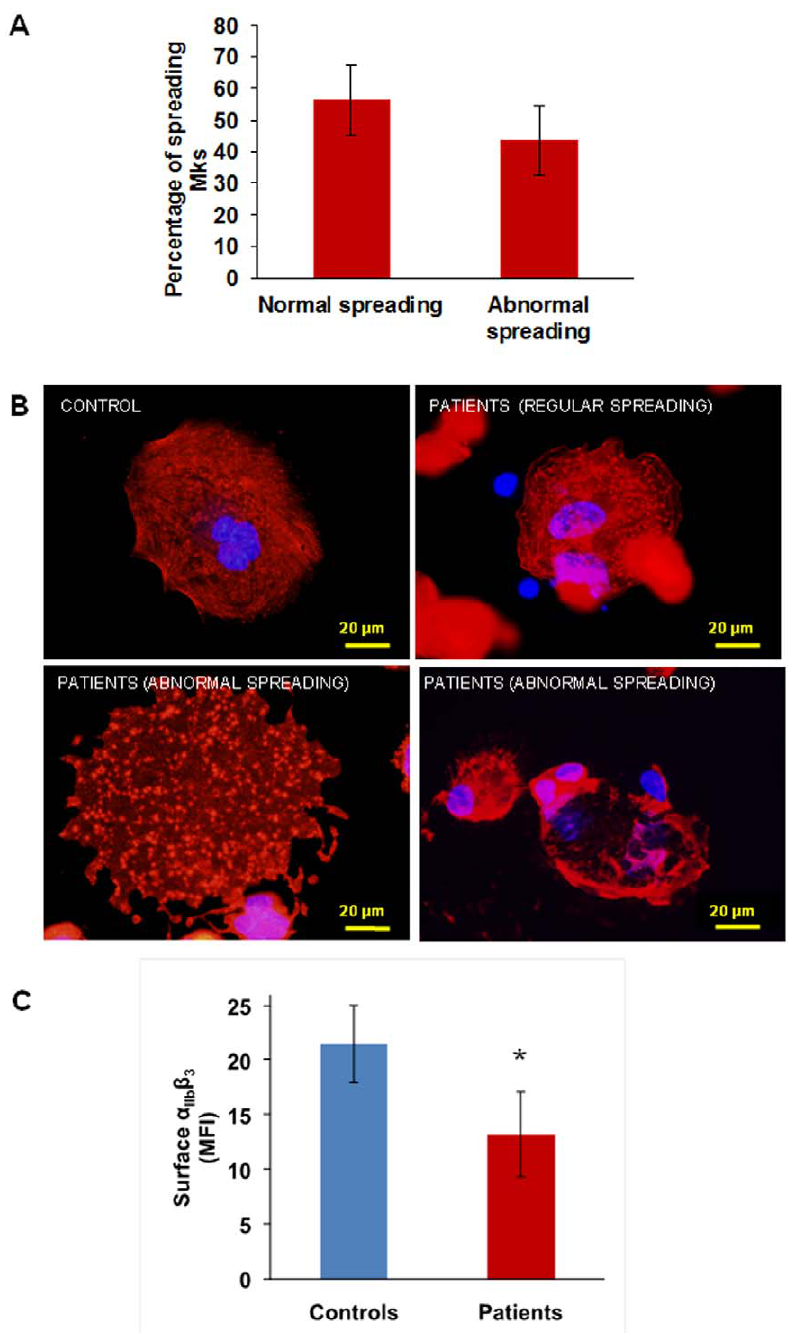
Figure 2. Megakaryocyte spreading on fibrinogen and a IIb b 3 expression. (A) and (B) When plated on fibrinogen two populations of megakaryocytes are visible: half of the population spread regularly, while half showed abnormal spreading, with nuclei displayed towards cell periphery, a disordered distribution of actin and focal adhesion points more evident than stress fibres. (C) Flow cytometry showed decreased expression of a IIb b 3 on the surface of patient’s megakaryocytes as compared with control megakaryocytes. *p , 0.05 vs control.